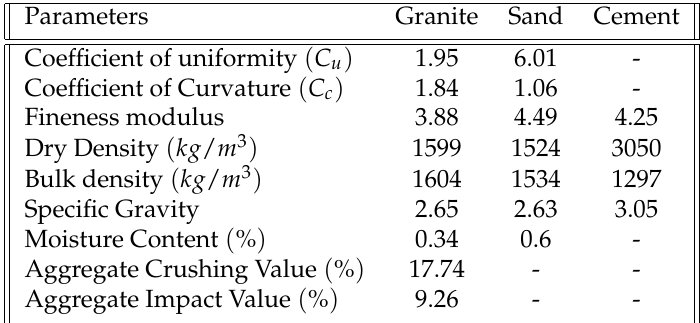
Table 2. Physical properties of concrete